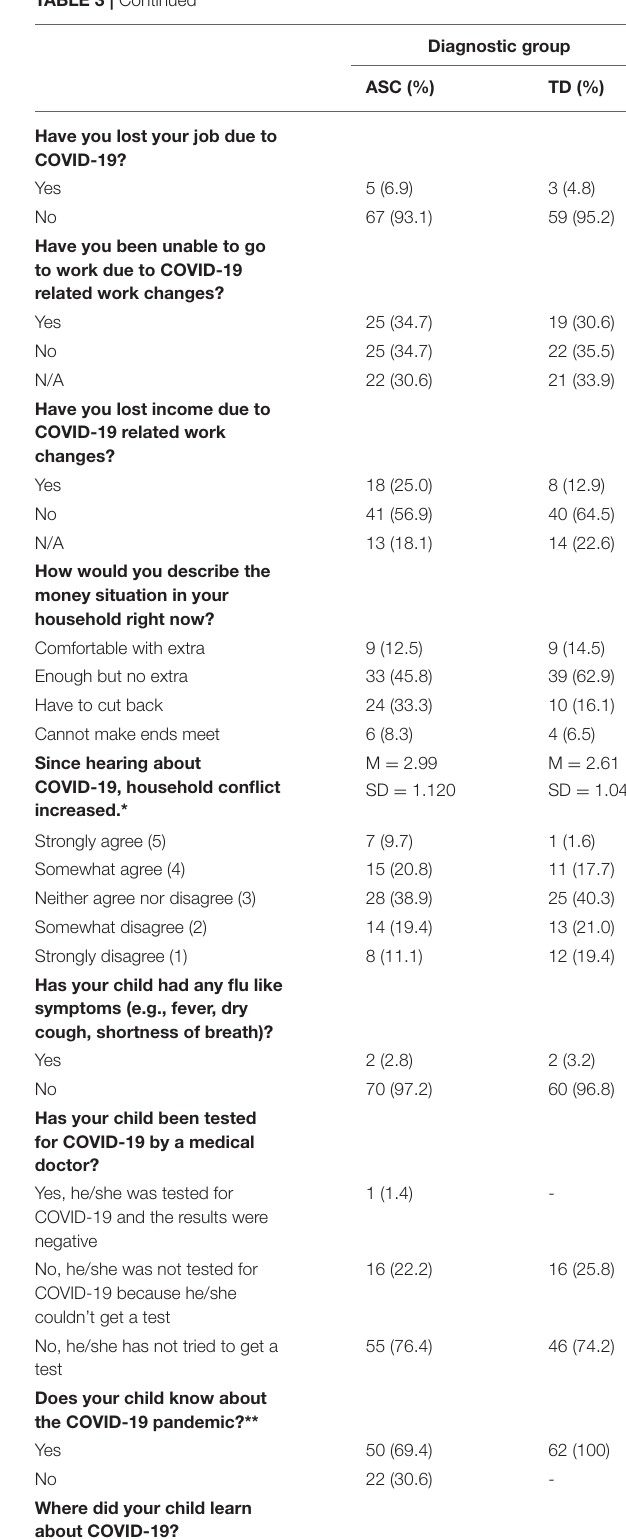
TABLE 3 | COVID-19 related questions